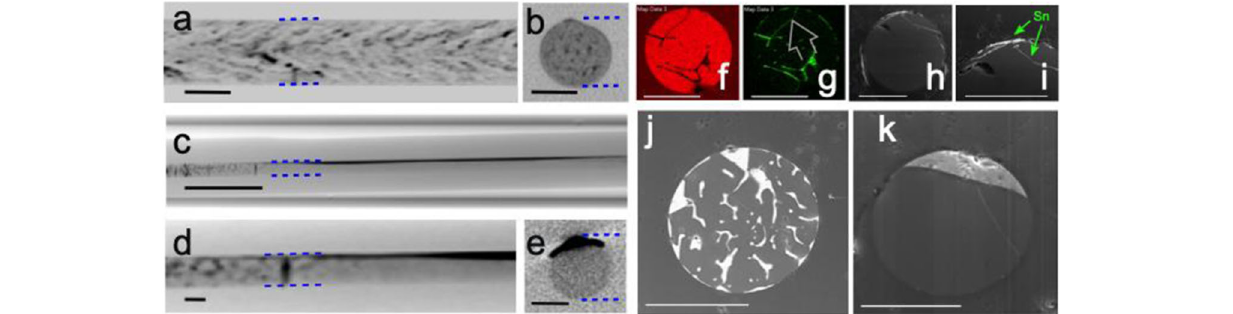
Fig. 3 Lateral segregation of fi bre components performed using the geometry of Fig. 1f. a – e are Si-Au, where dotted blue lines highlight the edges of the Si core and dark regions are Au; f – i are Si-Sn and j , k are Si-GaSb. a Side XCT of as-drawn Si-Au. b Cross sectional XCT of as-drawn Si-Au. c Overview XCT of Au-Si laterally segregated fi bre; dark line is Au electrode. d Enlarged view of the transition between as-drawn and segregated core regions. e Cross-sectional XCT of the segregated region showing Au along one edge. f EDS map of Si in Si-Sn composite as-drawn fi bre, g EDS of Sn in as-drawn fi bre, with arrow showing the direction of Sn movement during segregation, h Overview BSE of Si-Sn core after segregation, showing the core has little residual Sn, and i closeup of Sn region showing extrusion into stress crack in the silicon, indicated by arrow. j BSE image of as-drawn Si-GaSb core fi bre, and k Si-GaSb after segregation. Scale bars are 100 μ m except in c , where the bar is 1 mm. Si-GaSb The lateral segregation method can also be used for fi bres drawn with a mixture of semiconductors having a pseudo-eutectic phase diagram, such as Si- GaSb 18 . In Fig. 3j, k the formation of two distinct layers is demonstrated using this system. The power and scan rates were adjusted to allow thermomigration of the GaSb to the heated side of the fi bre, and graphite was used to maintain the other side of the fi bre below the melting point of pure silicon. Supplementary Movie 2 shows the segregation process. A thread of GaSb extruded into a stress-induced crack in the silicon core during solidi fi cation. This structure is a prototype for the formation of longitudinal diodes usable for solar conversion and photodetection. Preliminary investigation of longitudinal segregation for Bragg gratings are presented in Supplementary Information Fig.